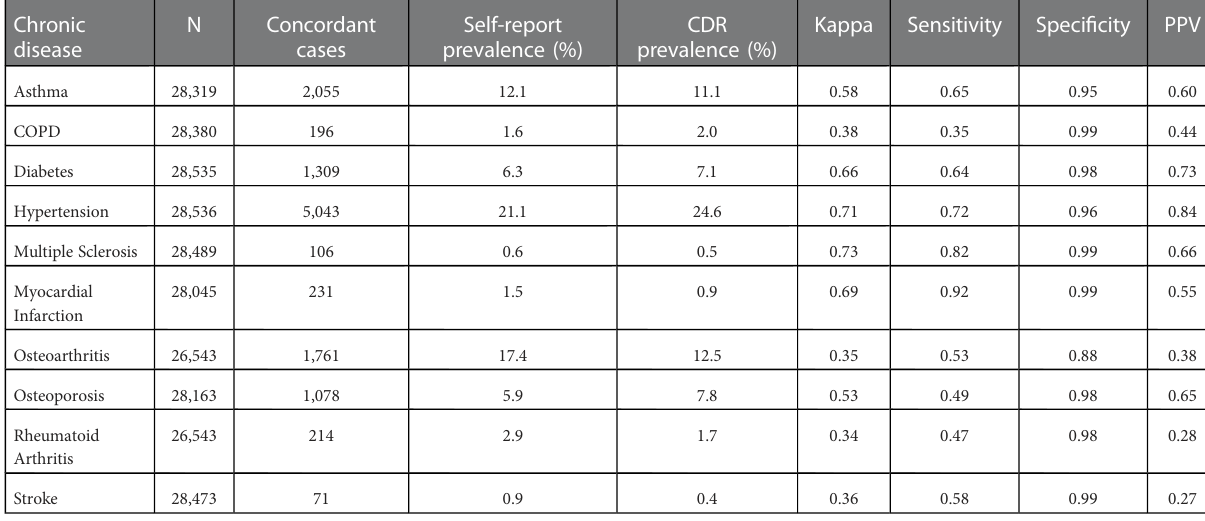
TABLE 2 Overall measures of agreement between registry and self-reported chronic diseases among participants of the BC generations project. Chronic